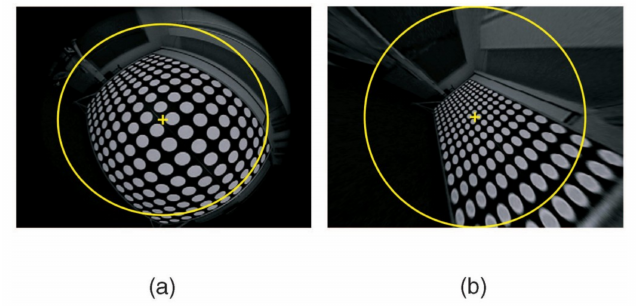
Figure 2. Method for calibrating image ( a ) to image ( b